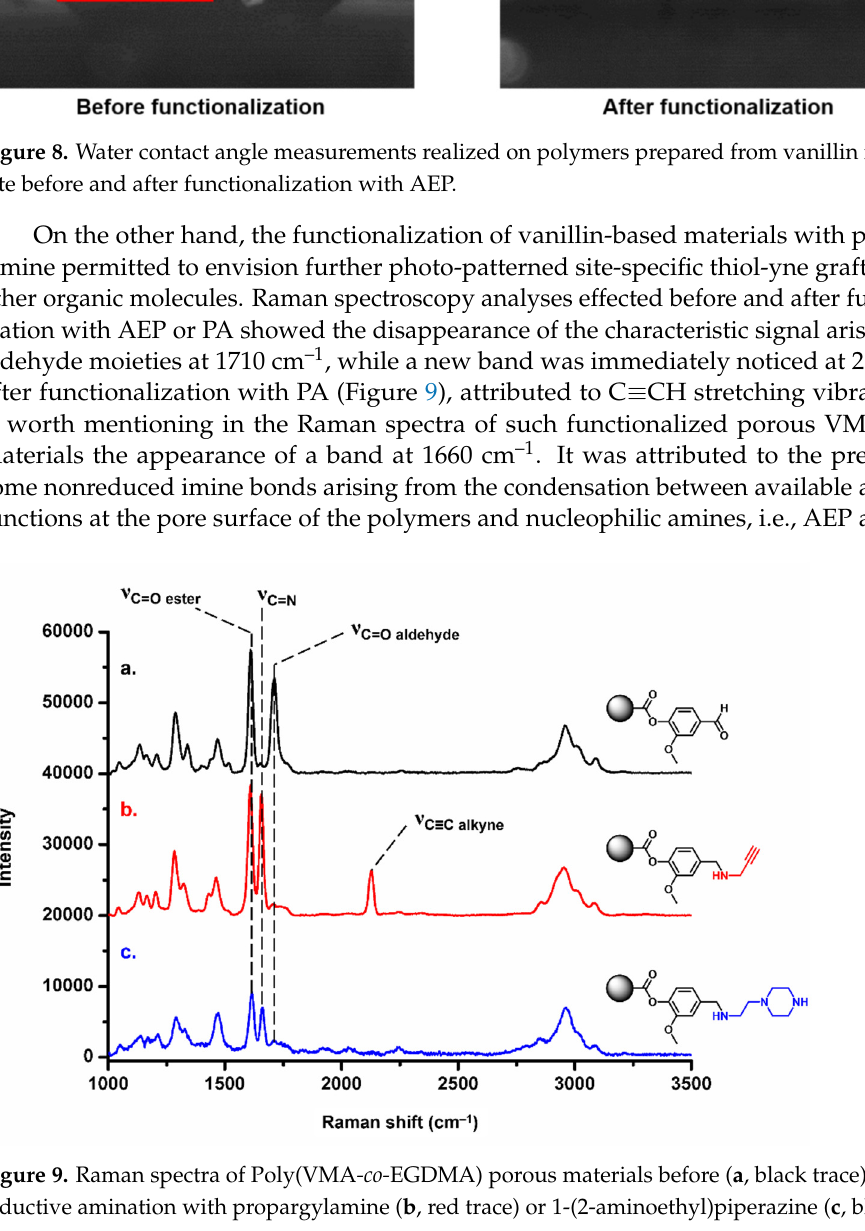
Figure 7. General scheme illustrating the pore surface functionalization of Poly(VMA -co- EGDMA)